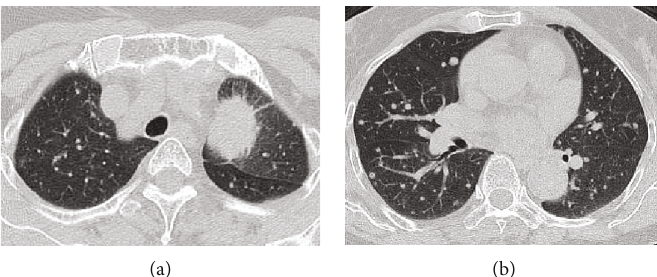
Figure 1: The patient was diagnosed with T4N1M1c Stage IVB lung adenocarcinoma with EGFR exon 19 deletion mutation presenting as (a) 40mm wide shadows in the upper lobe of the left lung and (b) multiple bilateral small nodules in the entire lung fi eld.